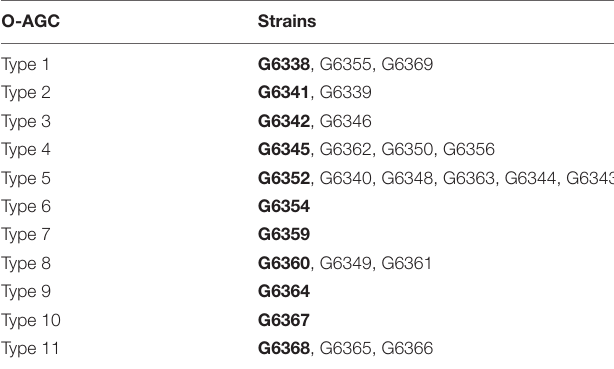
TABLE 1 | Strains used in this study and their allocation based on their O-AGC